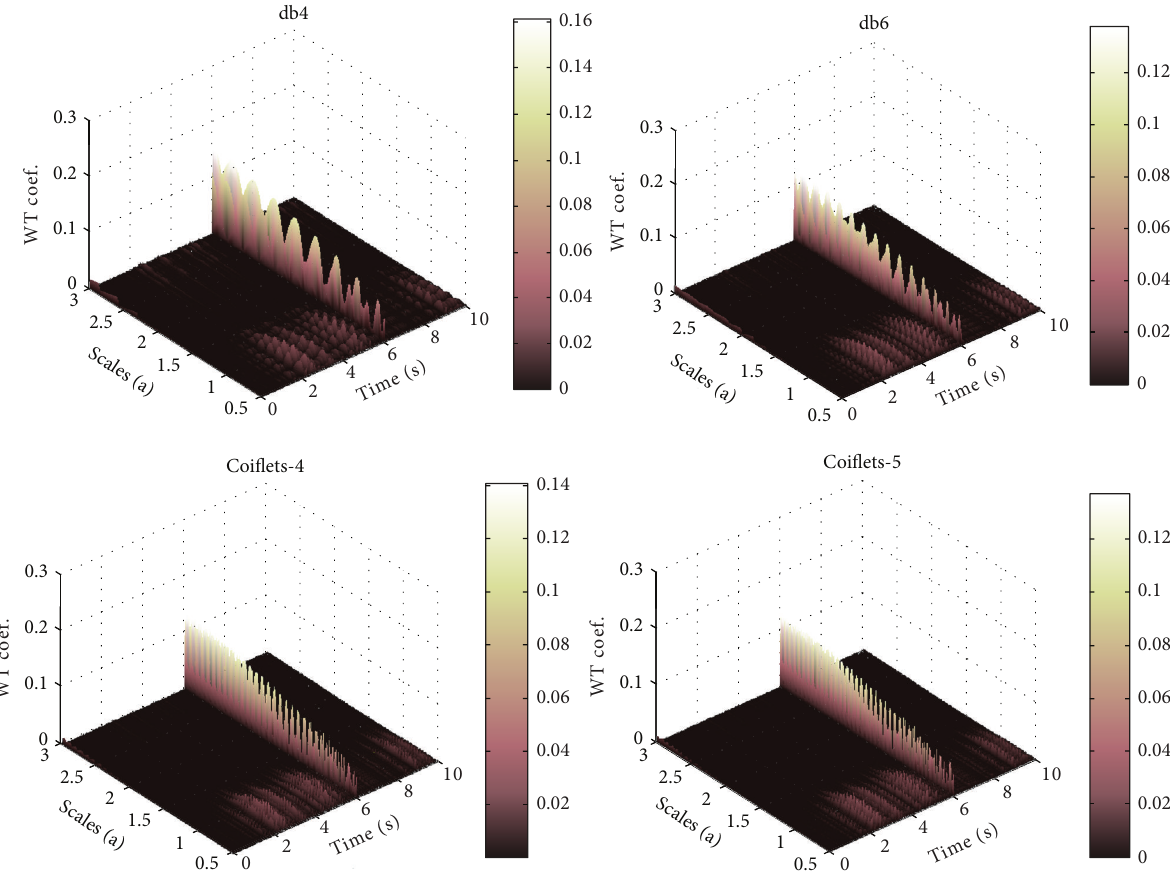
Figure 12: Variations of WT coefficients with different vanishing